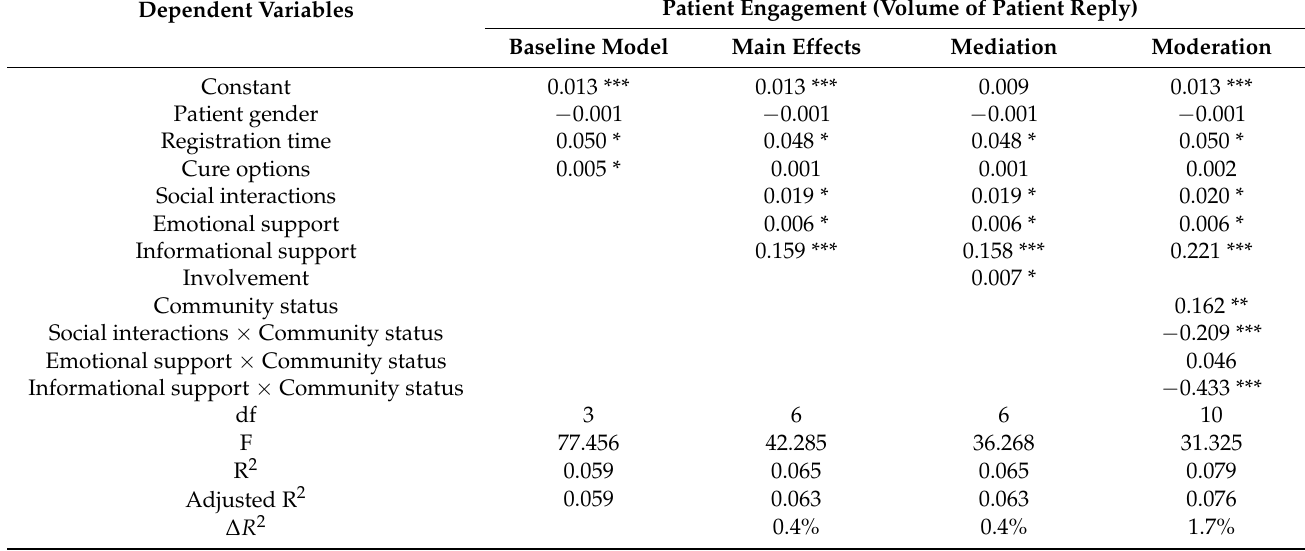
Table 7. Results of alternative measurement of patient engagement.